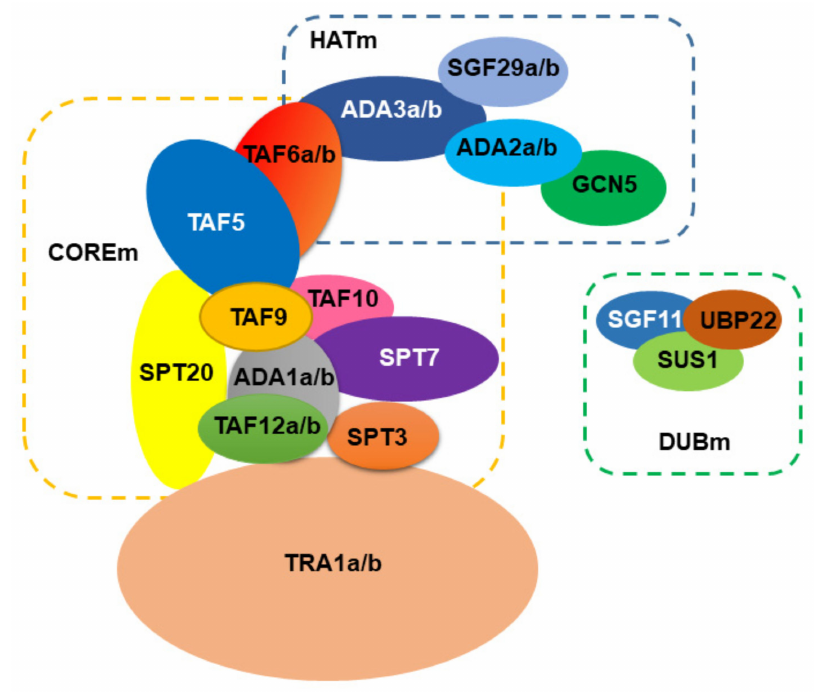
Figure 1. A model for the organization of SAGA complex in Arabidopsis .